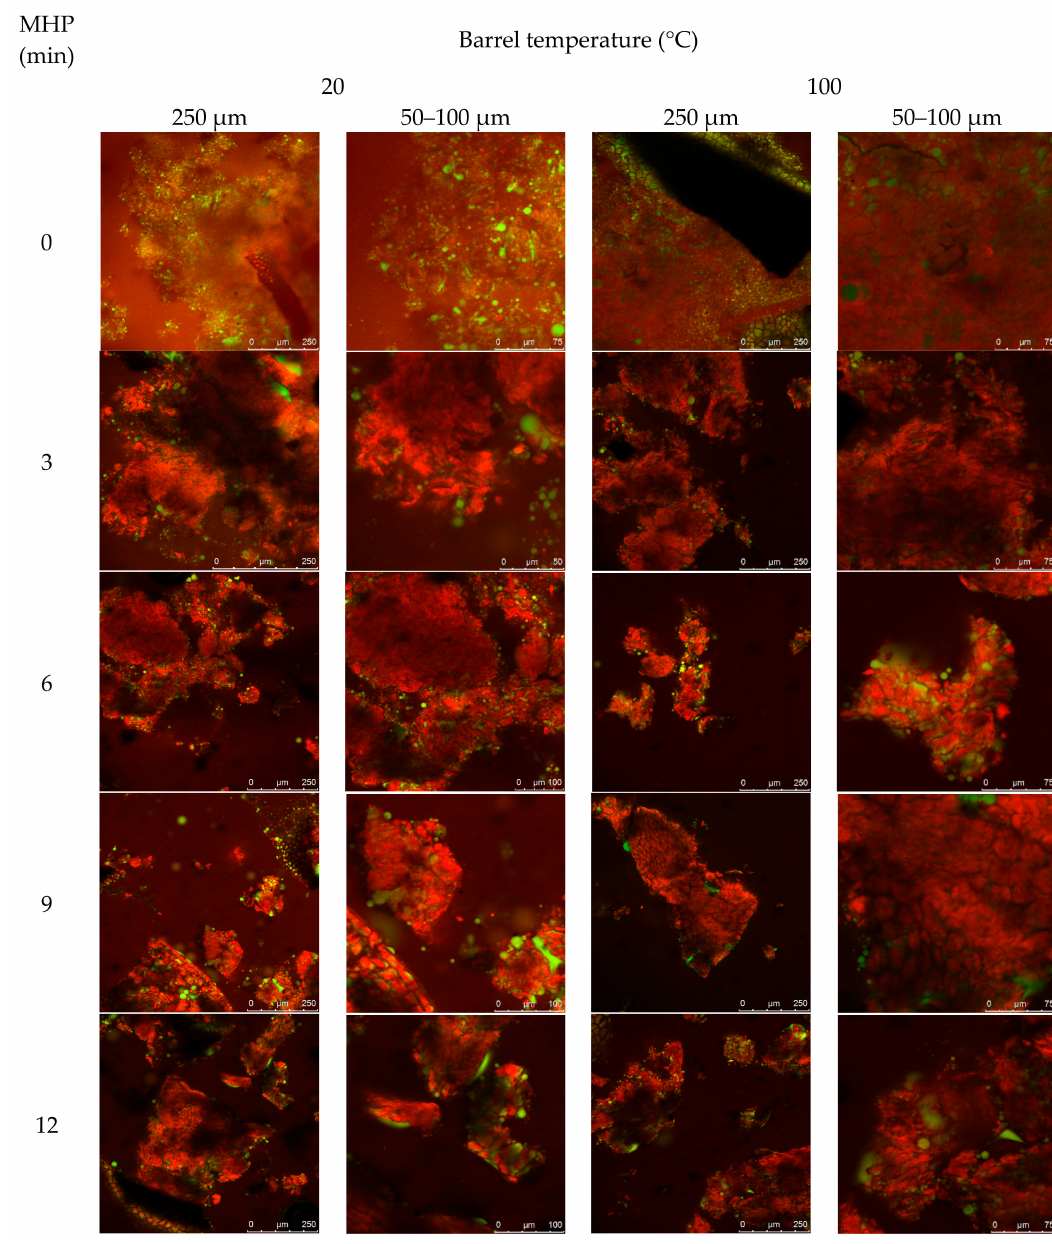
Figure A2. Representative confocal laser scanning micrographs of cold-pressed (20 ◦ C) and expeller (100 ◦ C) canola meal treated with increasing durations of moist heat pressure (MHP, 0–12 min). Protein is stained red with Nile Blue dye, and lipid is stained green with Fast Green FCF dye. Scale bars correspond to 250, 100, 75 or 50 µ